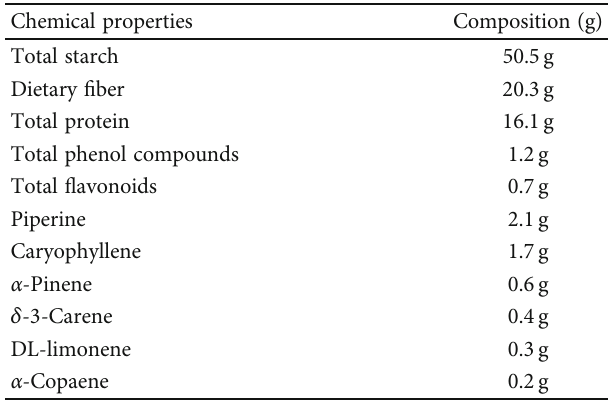
Table 1: Chemical composition of ground black